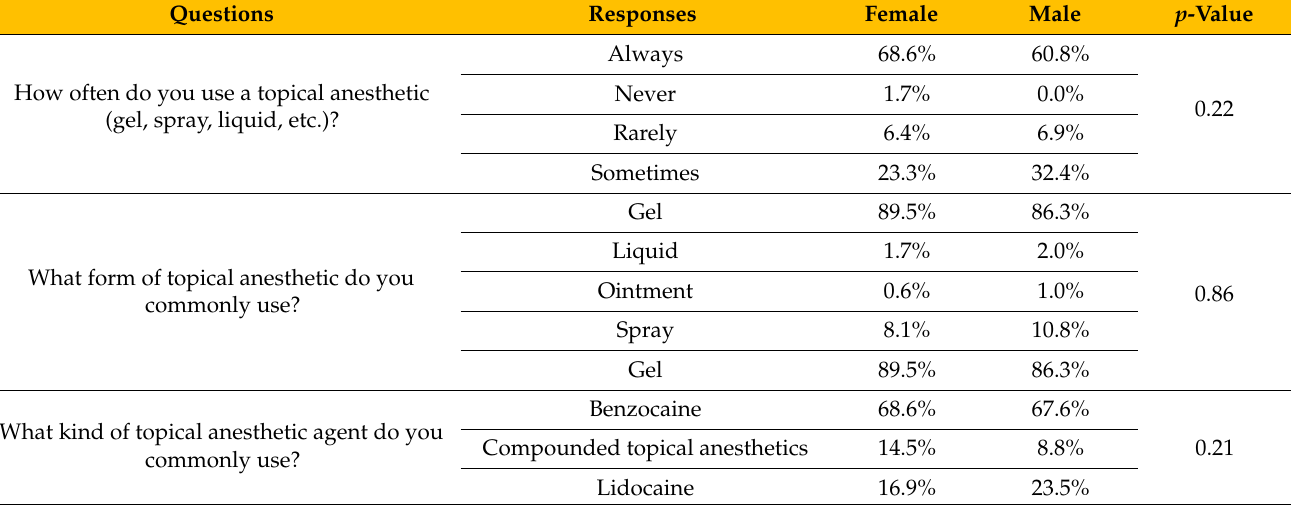
Table 5. Perceptions of topical anesthetics among Saudi dental practitioners based on